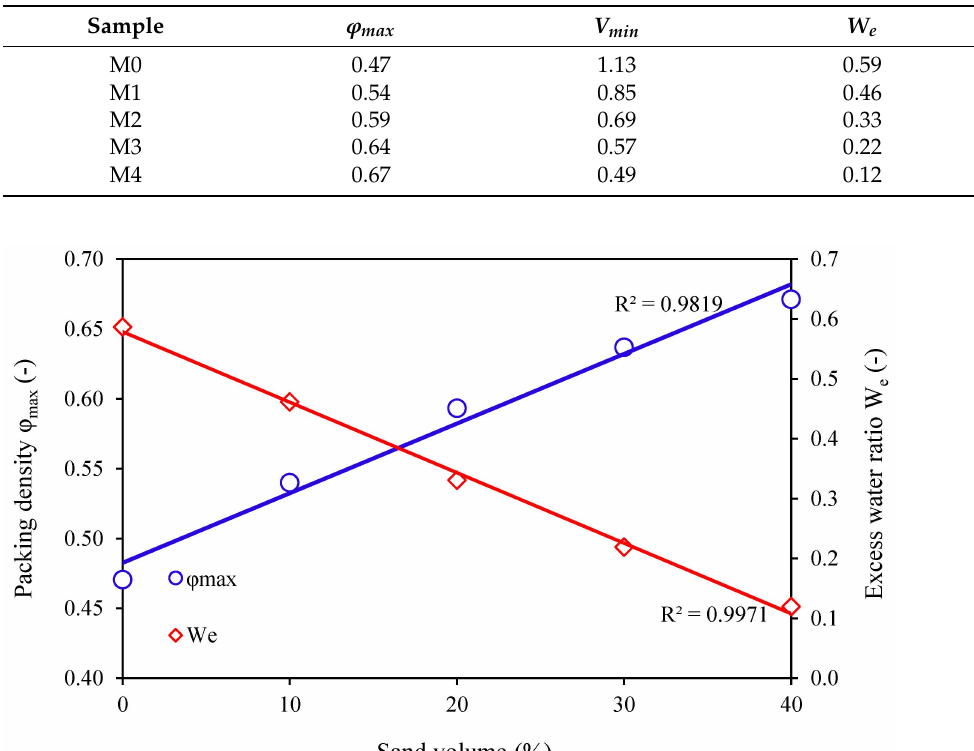
Table 4. Particle packing and excess water ratio.